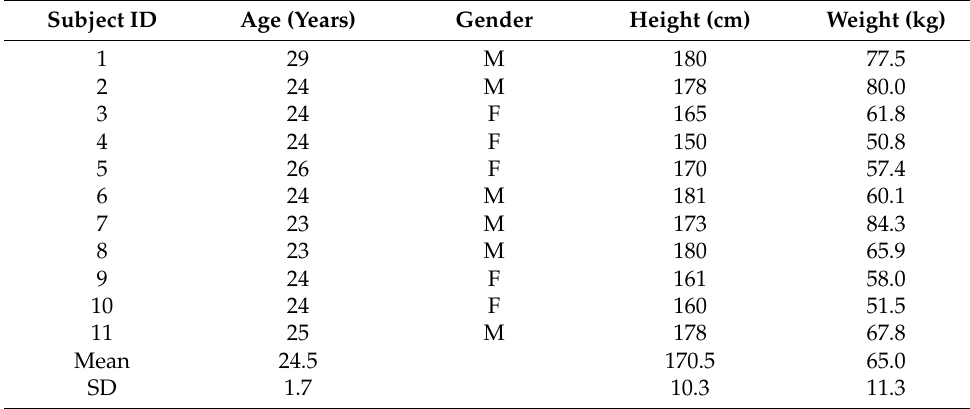
Table 1. Data and anthropometric characteristics of the